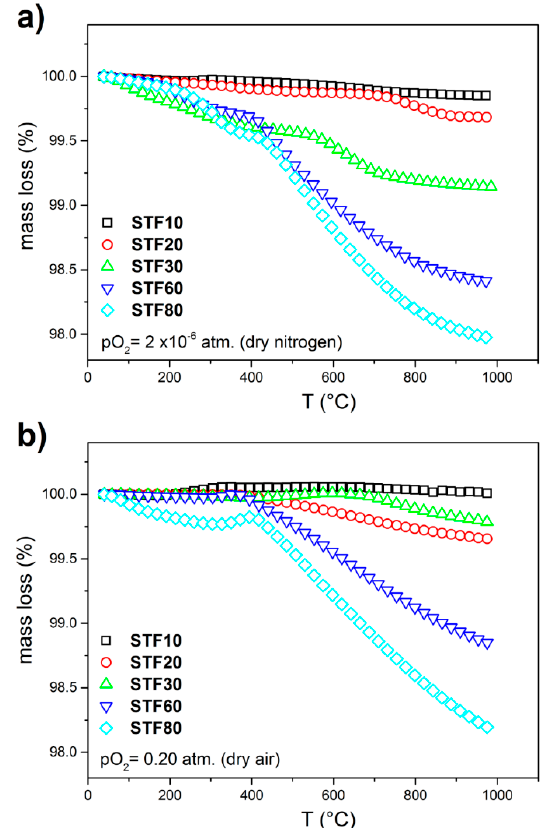
Figure 4. Mass loss in SrTi 1 − x Fe x O 3 − x / 2 − δ as a function of temperature measured by thermogravimetric